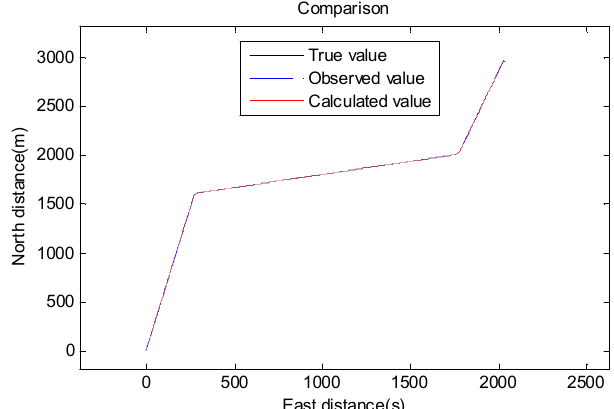
Sensors 2019 , 19 , x Figure 3. Schematic diagram of the autonomous underwater vehicle (AUV)’s motion.